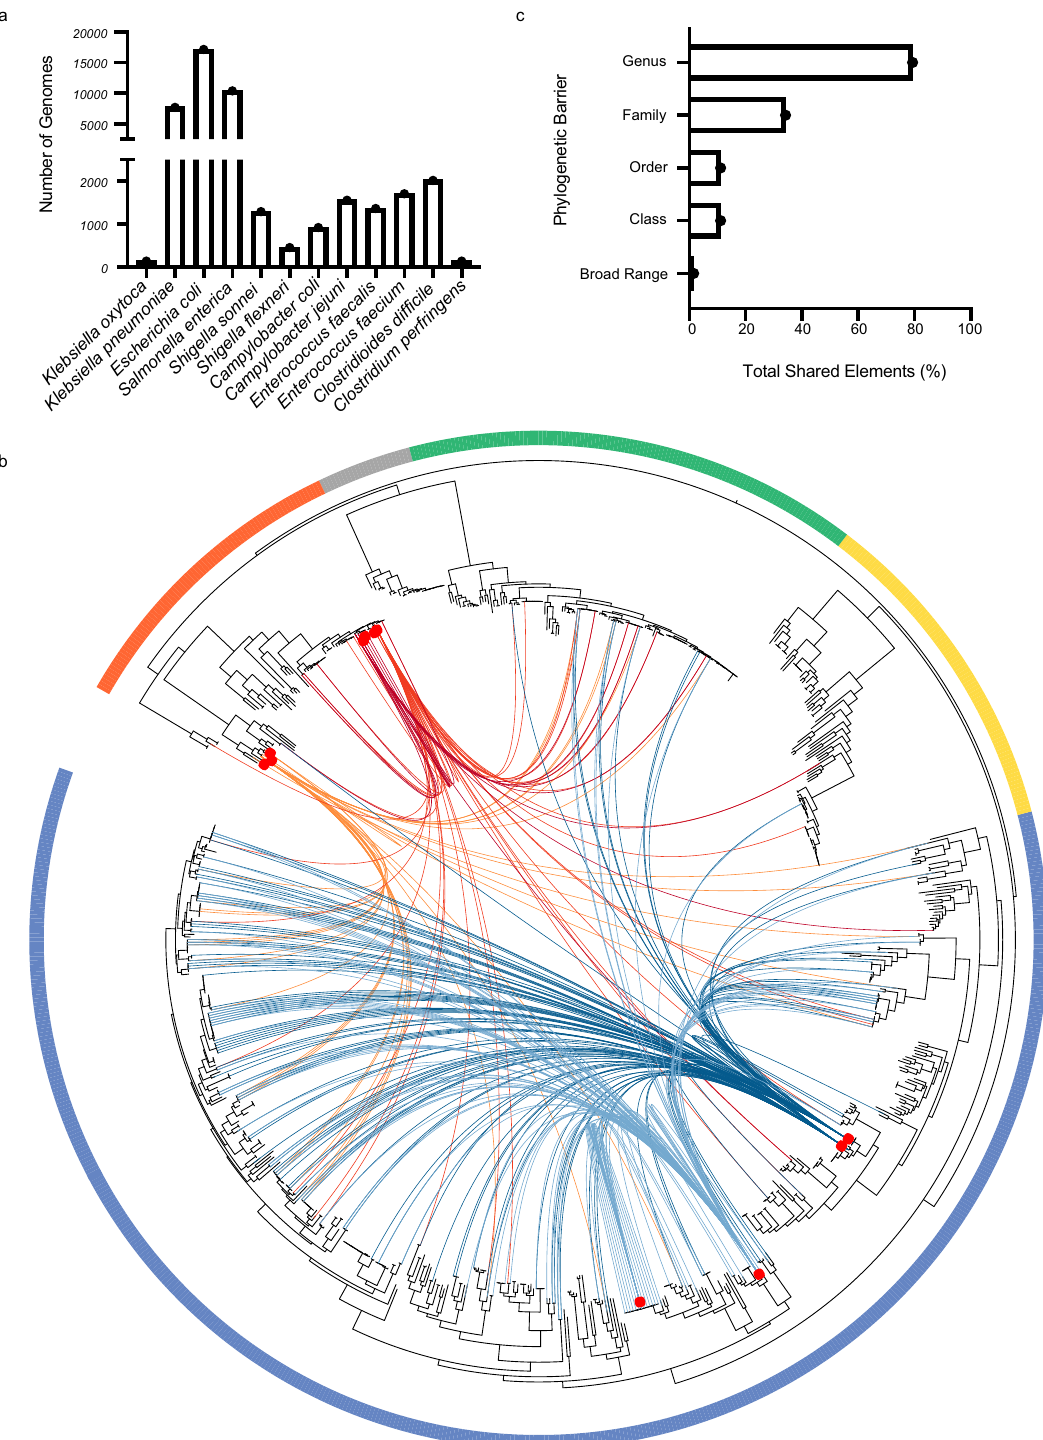
Fig. 1 Patterns of horizontally transferred genetic elements between gastrointestinal commensal and pathogen species. a Number of genomes from each of the twelve pathogenic species included in the analysis. b Actinobacteria (Gold), Bacteroidetes (Green), Firmicutes (Blue), Fusobacteria (Grey) and Proteobacteria (Orange) are indicated by the surrounding border. Red boxes indicate location of pathogens on the phylogenetic tree. Connecting lines indicate shared putative horizontally transferred genes. Links from Escherichia (Red), Klebsiella (Dark Red), Campylobacter (Orange), Enterococcus (Dark Blue), and Clostridia (Light Blue) pathogens are shown. c Phylogenetic barriers of MGE demonstrating inter-genus (79.3%), inter-family (34.2%), inter- order (11.14%), inter-class (11.12%) and broad host range, inter-phyla (1.5%) horizontal